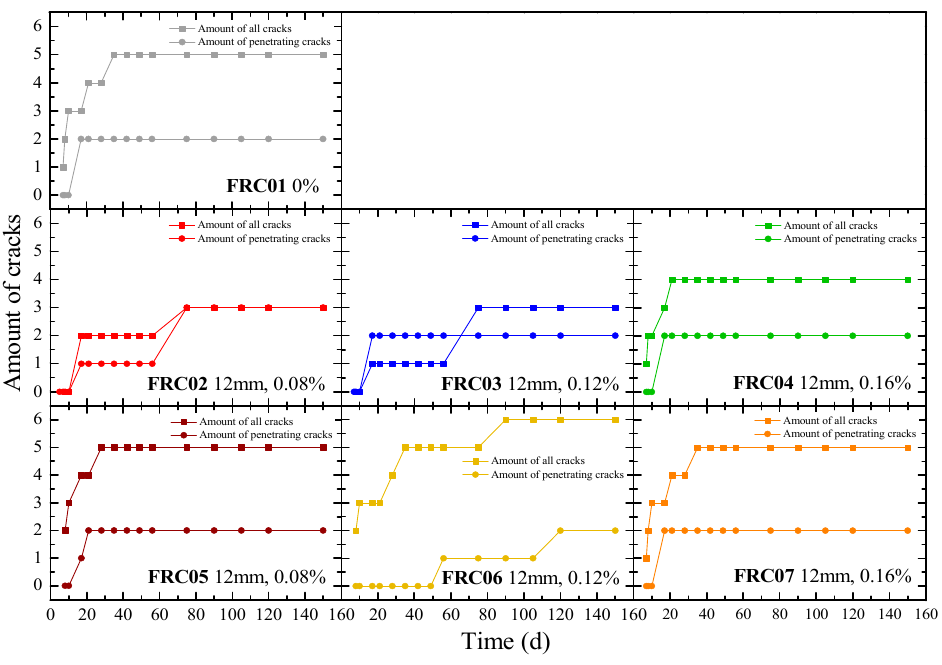
Figure 14. Amount of cracks in circular concrete specimens during 150 days.